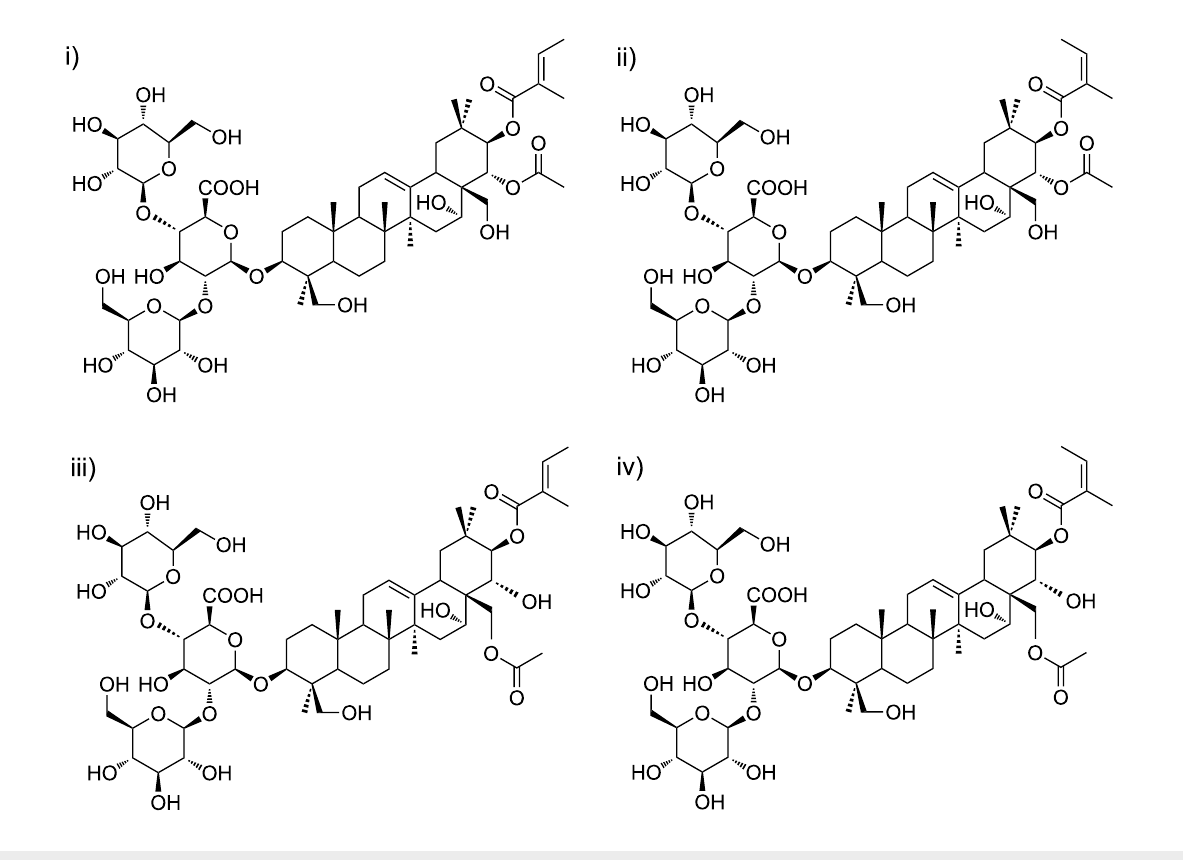
Figure 1: Isomeric structures for (top line) aescin Ia (i) and aescin Ib (ii) and for (bottom line) isoaescin Ia (iii) and isoaescin Ib